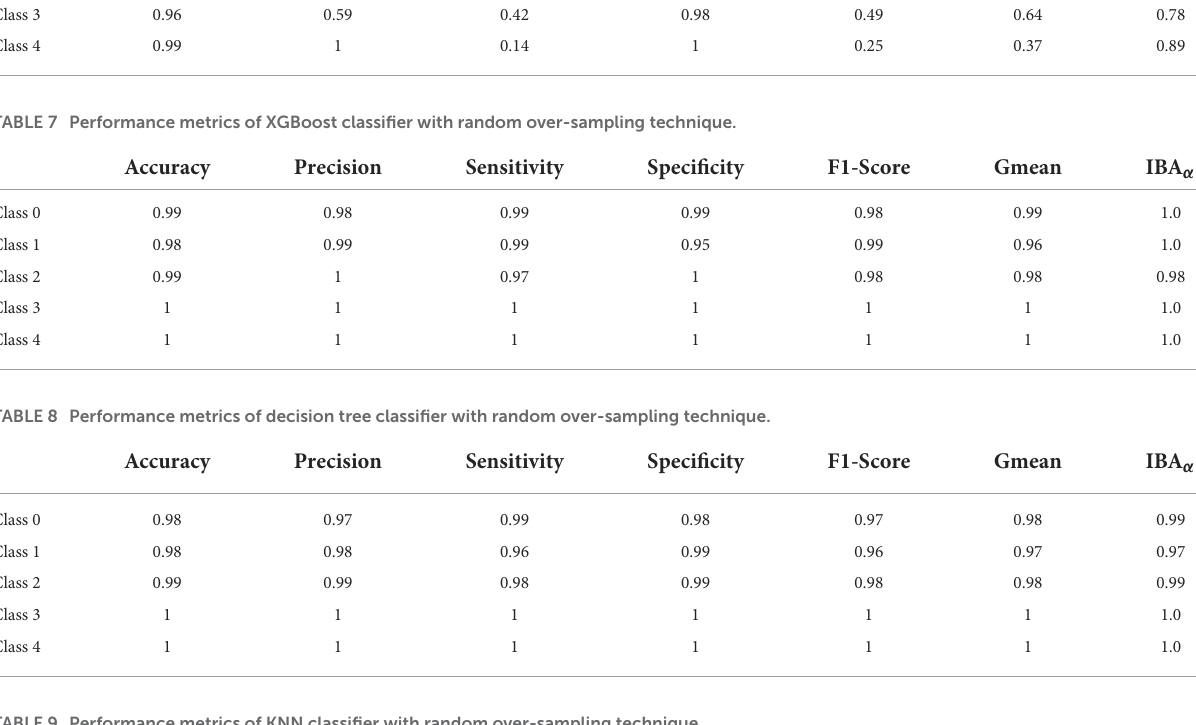
TABLE 9 Performance metrics of KNN classifier with random over-sampling